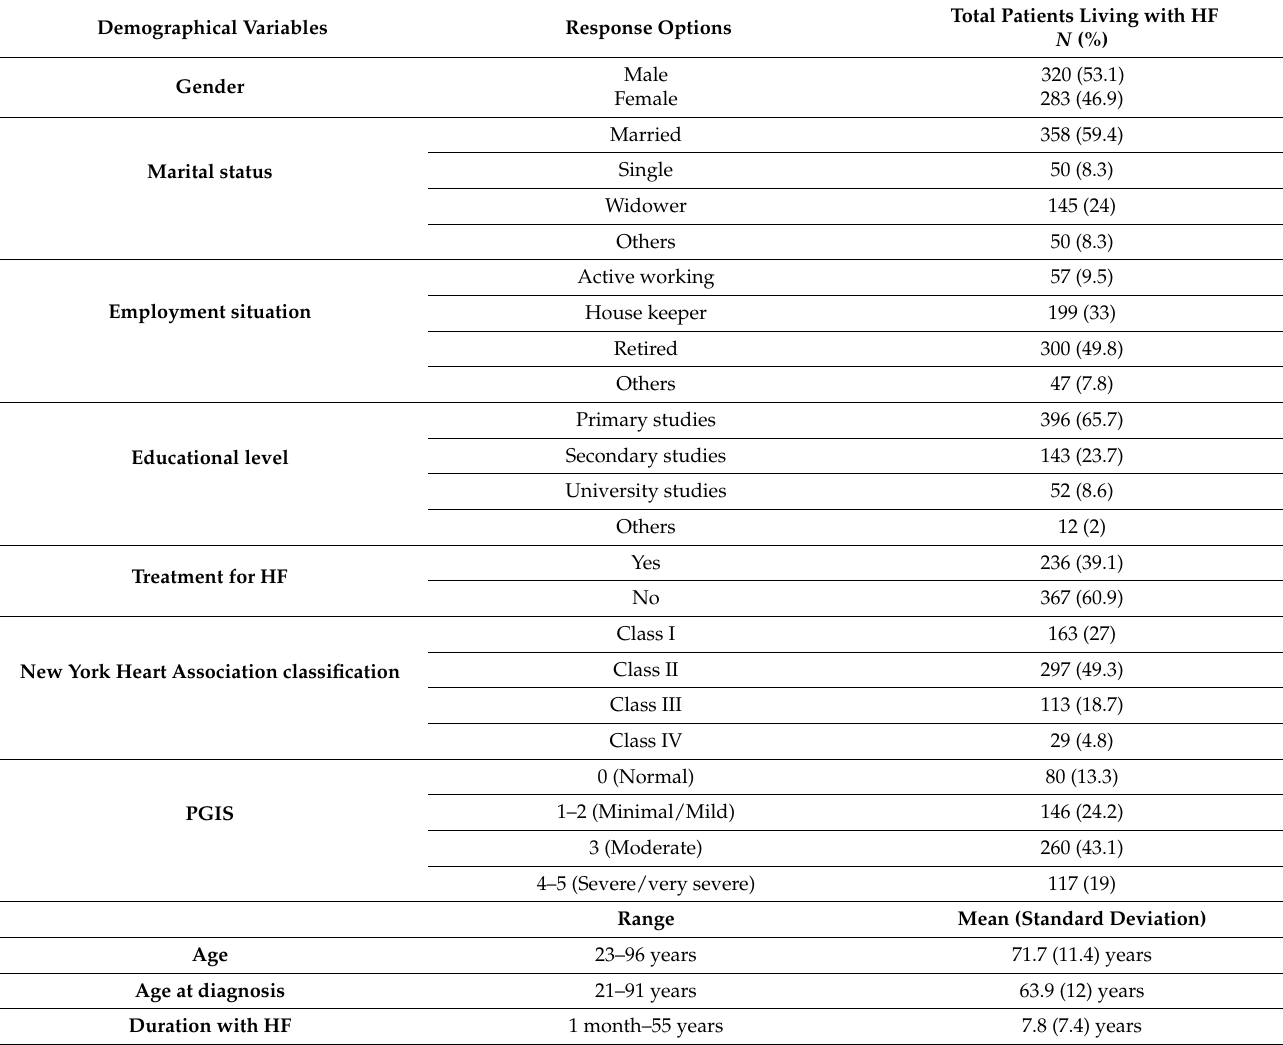
Table 1. Sociodemographic characteristics of the patients ( n = 603) and historical data of the disease. Demographical